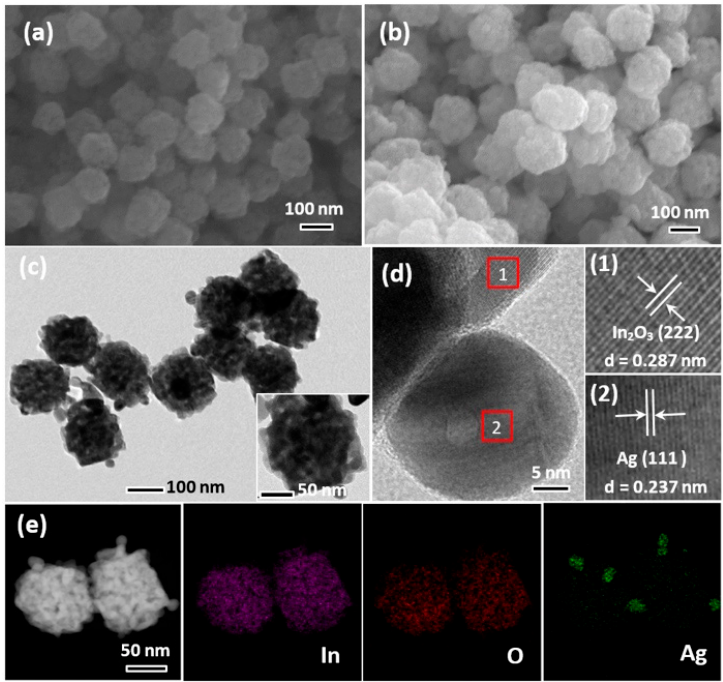
Figure 2. FESEM images of ( a ) bare In 2 O 3 and ( b ) Ag/In 2 O 3 -2. Typical ( c ) TEM and ( d ) HRTEM images of Ag/In 2 O 3 -2. ( e ) EDS element maps of two adjacent Ag/In 2 O 3 PNSs observed in Ag/In 2 O 3 -2. The inset in ( c ) is an enlarged TEM image of a single Ag/In 2 O 3 PNS. The surface chemical state of bare In 2 O 3 and Ag/In 2 O 3 -2 was investigated by XPS (Figure 3). In their full XPS spectra (Figure 3a), the signals from In, O, and C are clearly observed. The signals of C in the two samples are ascribed to the contaminated car- bon. Compared with bare In 2 O 3 , additional signals arising from Ag 3d are presented in Ag/In 2 O 3 -2, further confirming the successful introduction of Ag in In 2 O 3 . Figure 3b shows the high-resolution XPS spectra of In 3d. In the bare In 2 O 3 sample, the peaks at the binding energy of 451.65 and 444.11 eV belong to In 3d 3/2 and In 3d 5/2 , respectively. In comparison with bare In 2 O 3 , the In 3d 3/2 and In 3d 5/2 peaks of Ag/In 2 O 3 -2 shift slightly to higher binding energy, which are located at 451.77 and 444.22 eV, respectively. The different binding energies of In 3d in the two samples suggest an electronic interaction between Ag and In 2 O 3 because of their different work functions [57]. In the high-resolution XPS spec- trum of Ag 3d of Ag/In 2 O 3 -2 (Figure 3c), the Ag 3d 5/2 (367.63 eV) and Ag 3d 3/2 (373.63 eV) peaks with 6 eV splitting demonstrate the existence of Ag 0 [54,58], being consistent with above TEM analysis. Compared with the standard binding energy of Ag 3d 5/2 (368.2 eV) and Ag 3d 3/2 (374.2 eV) in metallic Ag, such two peaks in Ag/In 2 O 3 -2 shift slightly to the lower binding energy side, which can be also ascribed to the interaction of Ag with In 2 O 3 . Figure 3d shows the high-resolution XPS spectra of O1s. After deconvolution, the signals of O1s can be divided into three peaks, including lattice oxygen (O Latt ) at about 529.60 eV, surface adsorbed oxygen (O ads ) at about 531.24 eV, and surface OH groups (O OH ) at about 532.08eV [33,59], and their relative percentages are listed in the inset. The estimated percentage of O ads in Ag/In 2 O 3 -2 is 48.48%, which is higher than that in bare In 2 O 3 (34.79%). It was generally believed that during the gas sensing process, the surface chemisorbed oxygen species, including O 2 − , O − , and O 2 − , can play the role of oxidant to react with reducing gas. Therefore, the higher O ads content is usually favorable for enhanced gas